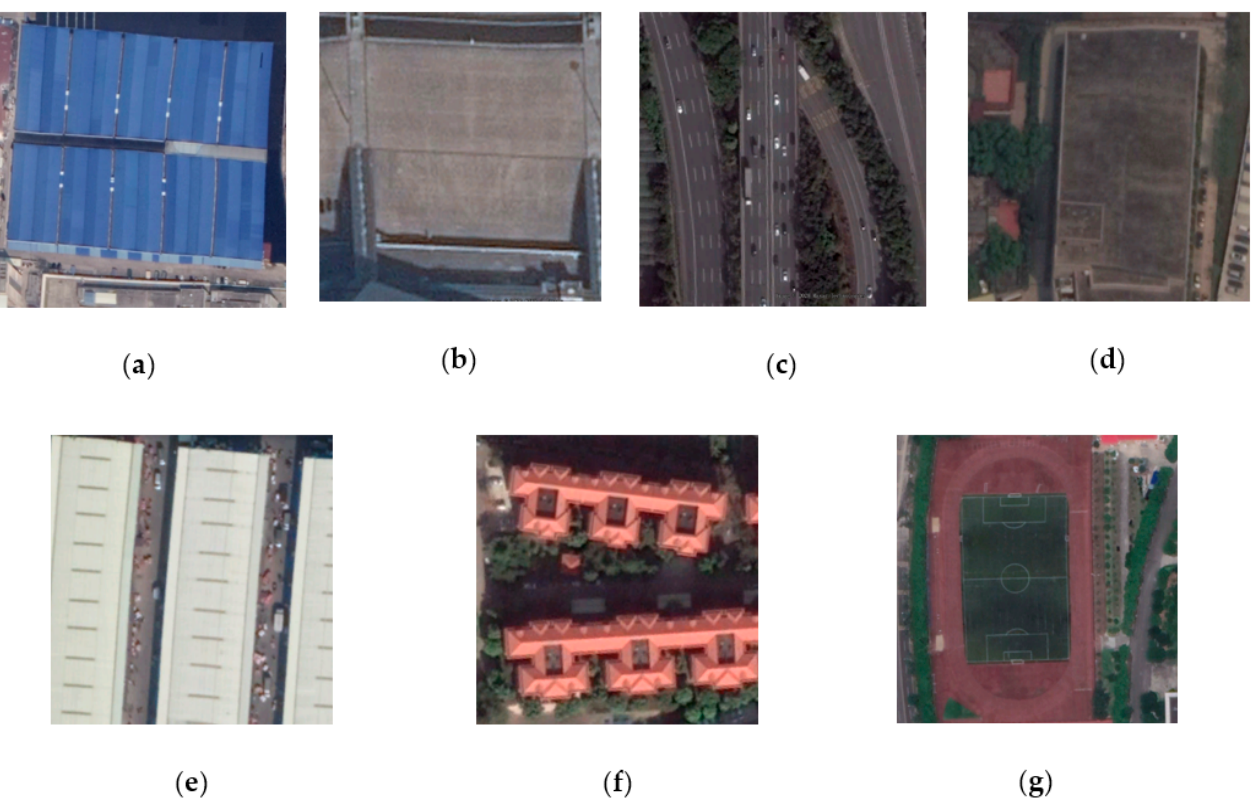
Figure 5. Detailed classification of ground objects ( a ) blue steel; ( b ) cement; ( c ) asphalt; ( d ) other impervious surface; ( e ) other metal; ( f ) brick; ( g ) plastic.